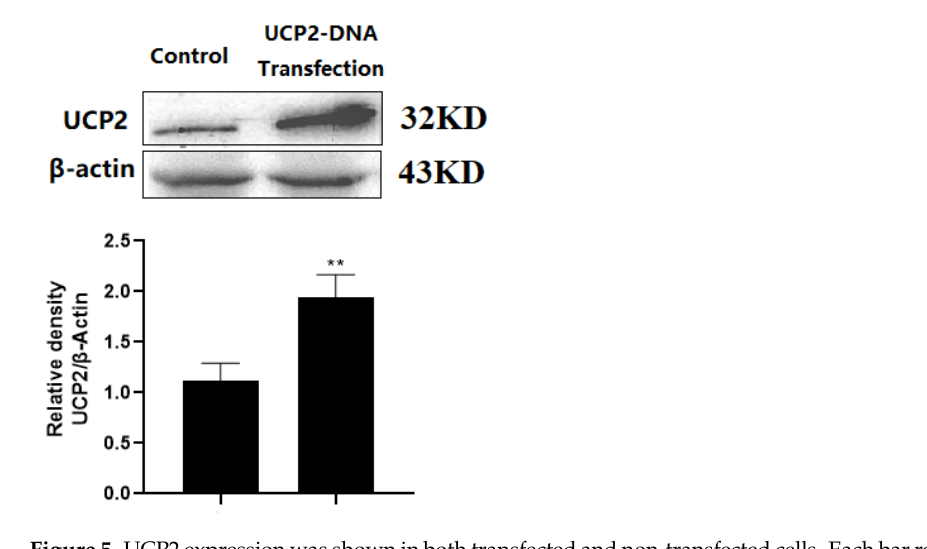
Figure 5. UCP2 expression was shown in both transfected and non-transfected cells. Each bar represents the mean ± SD of three independent experiments (** p < 0.01 vs. Control group). As is shown in Figure 6A, compared with non-transfected cells, the HK-2 cells with high expression of UCP2 could significantly recover from AA I-induced cytotoxicity. Figure 7A,B show that the viability of transfected cells treated with different concentra- tions of AA I with or without genipin (25 µ M) was significantly higher than that of non- transfected cells. In addition, the IC50 (Table 2) value of transfected cells treated with AA I with or without genipin was also higher than that of non-transfected cells. These results revealed that the toxicity of AA I on transfected cells was